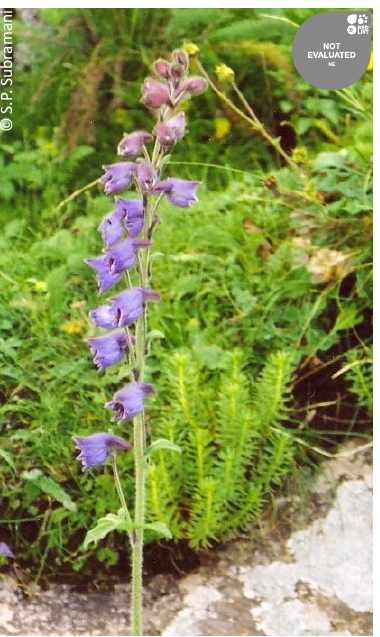
Image 40. Delphinium vestitum Wall. ex Royle